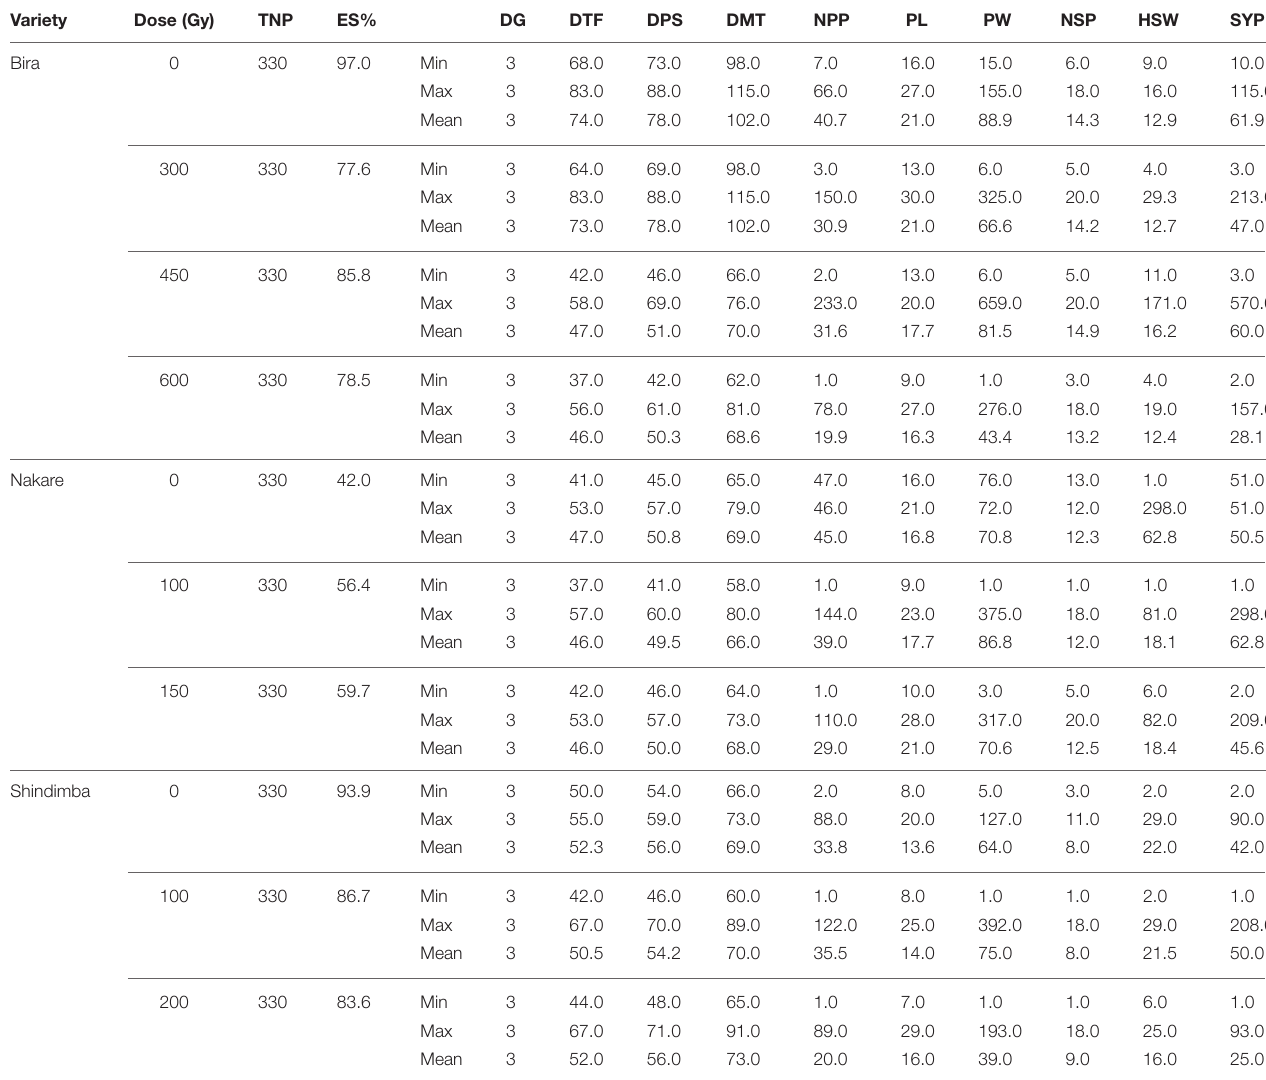
TABLE 6 | Quantitative characteristics of M 5 cowpea mutant lines irradiated at different gamma radiation doses (Gy) in relation to their parental lines/control observed at Omahenene Research Station during 2013/2014 season. Variety Dose